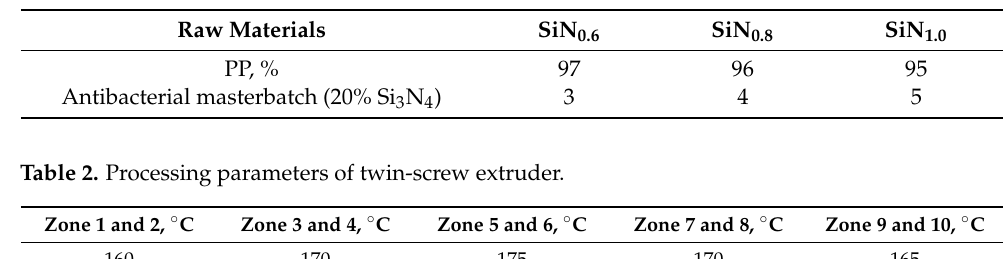
Figure 1. Preparation of PP/Si 3 N 4 pellets: ( a ) twin ‐ extruder process diagram, ( b ) PP/Si 3 N 4 mas- terbatch and other pellets. Table 1. The recipe of raw materials for MB nonwovens.